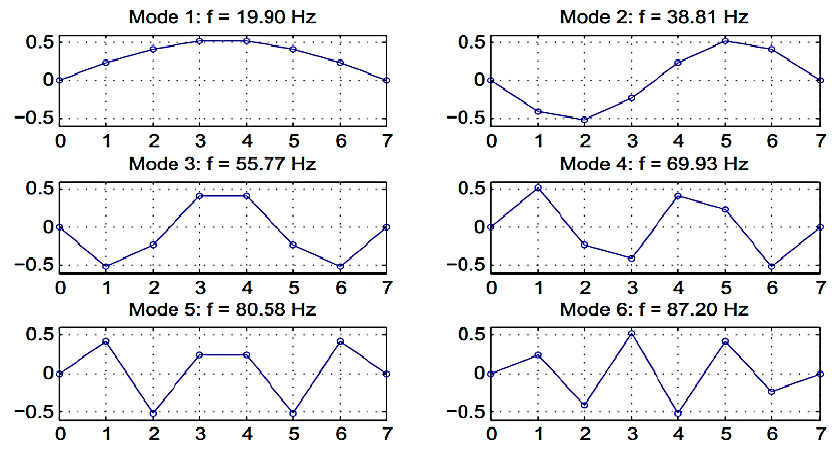
Figure 5. The mode shapes and natural frequencies of the simulation mass–spring–damper system without considering damping effects.